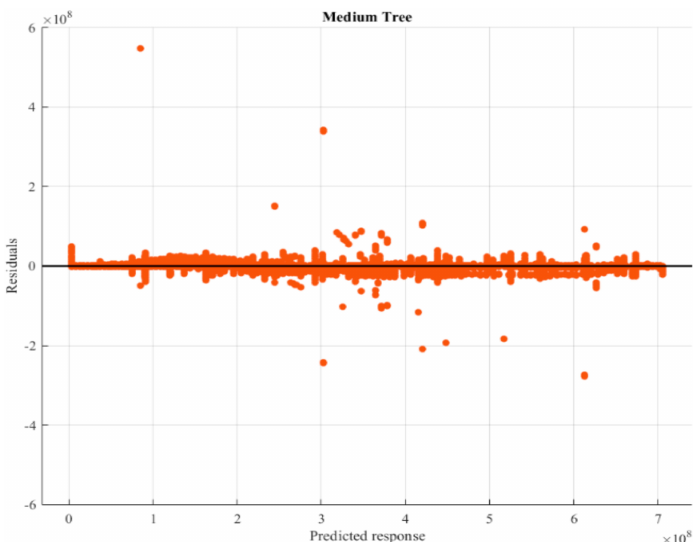
Figure 15. Medium Trees Residual training.